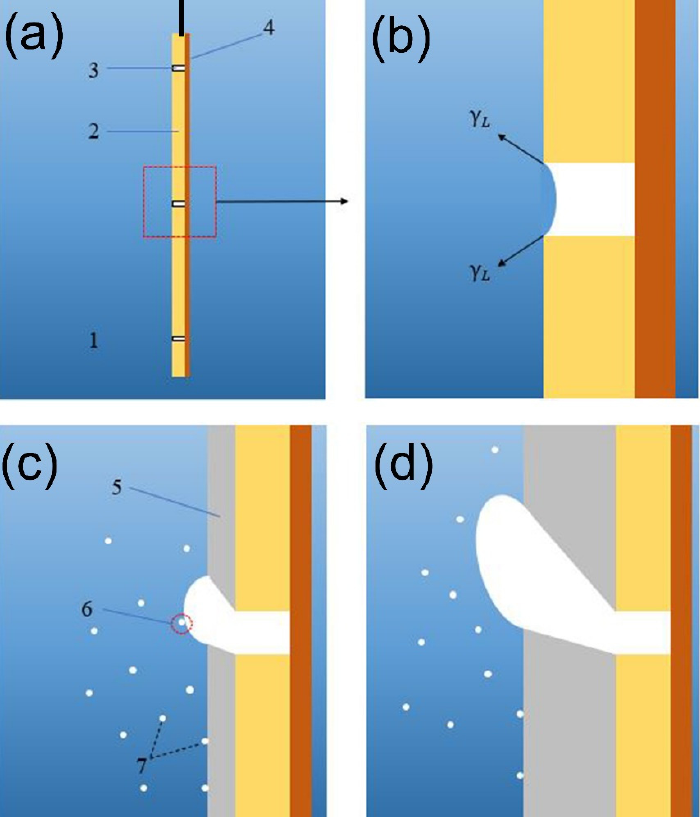
Figure 4. The formation process of bell-mouthed macropores in the deposition: ( a ) the substrate is placed in the solution; ( b ) state of micropores before electrodeposition; ( c ) electrodeposition begins and macro-bubbles are formed; ( d ) bubbles and deposition in electrodeposition. (1, bath solution; 2, Hull copper sheet; 3, micropore on the copper sheet; 4, insulating layer; 5, nickel deposition; 6, micro-bubbles merging with bubbles on the cathode; 7, micro-bubbles generated on the cathode and dissolved in the solution)